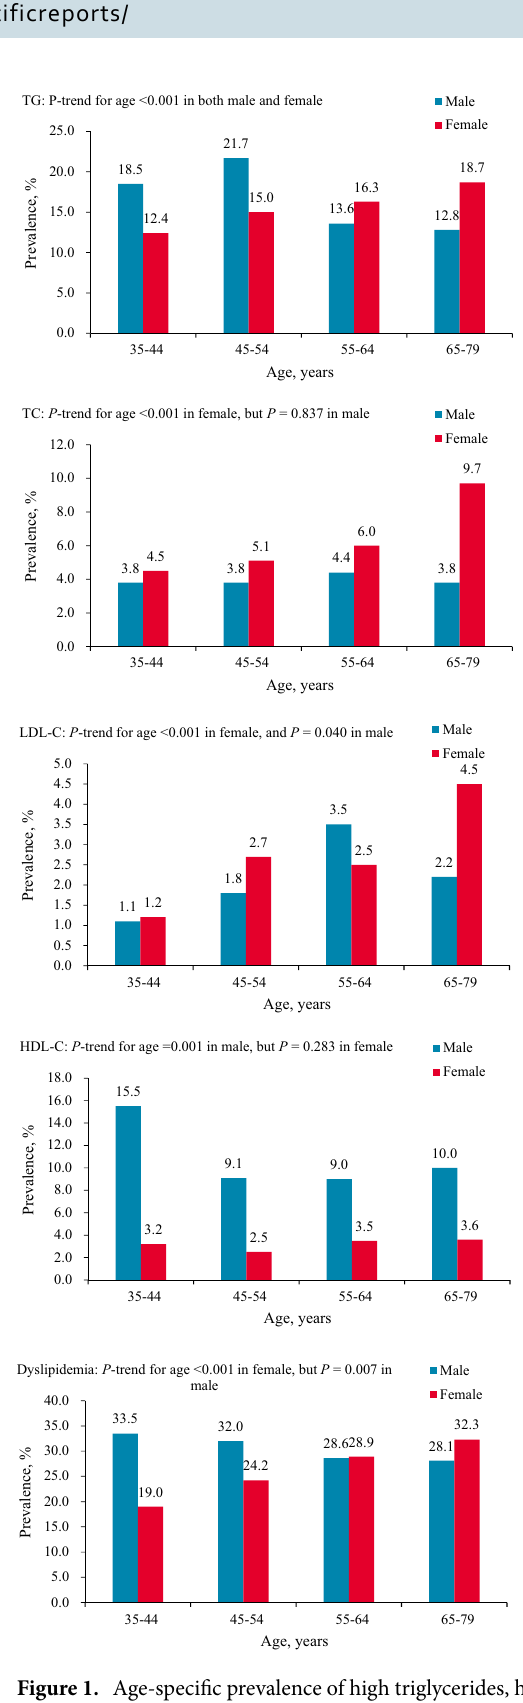
Figure 1. Age-specific prevalence of high triglycerides, high total cholesterol, high low-density lipoprotein cholesterol, low high-density lipoprotein cholesterol, and dyslipidemia among adults aged ≥ 35 years in Southwestern